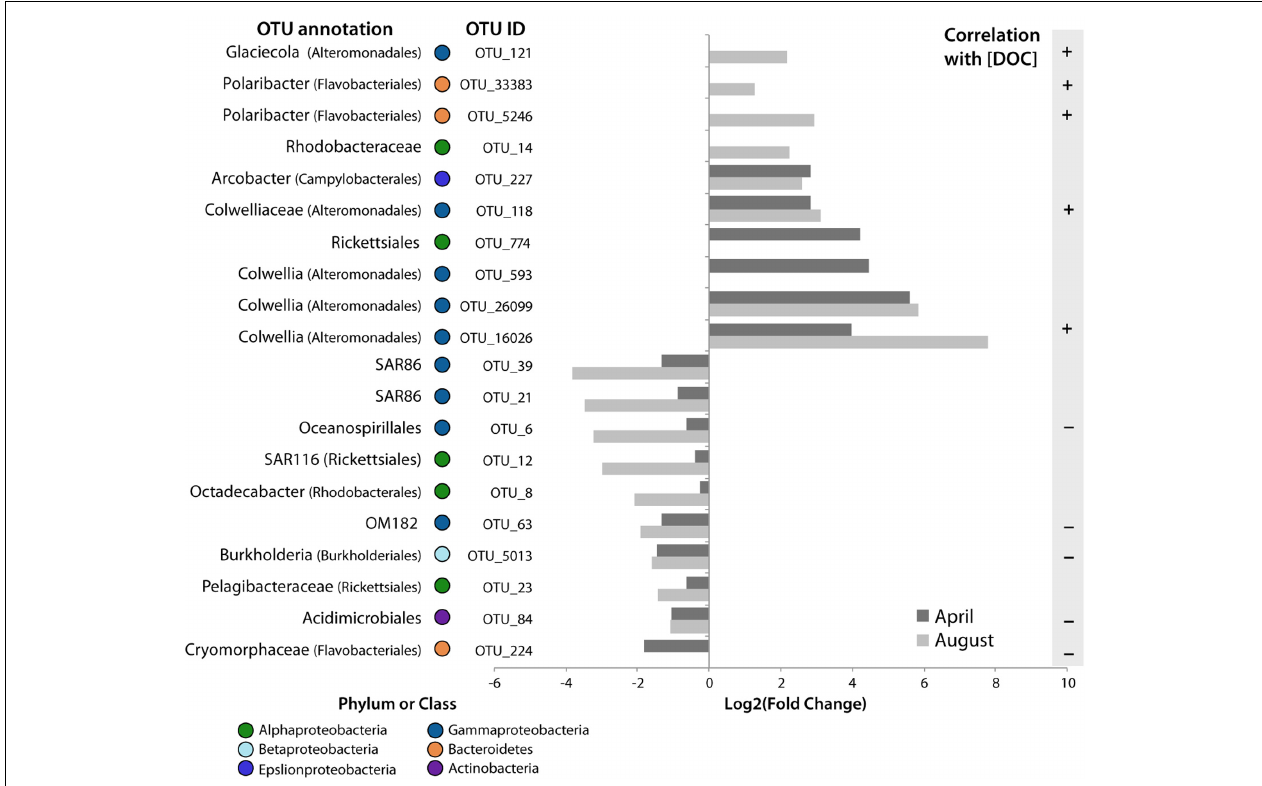
FIGURE 7 | Potential sentinels of increasing tDOM. Log2 of the fold change in relative abundance of OTUs that were found to significantly increase or decrease in tDOM bioassays only. The amount of change at 4 days in each bioassay is plotted. Taxonomic classification of the OTU is noted to the right of the OTU# (more detailed classifications are provided in Figure 2 ). The presence of a significant ( p < 0.05) correlation with DOC concentration is also indicated to the right of the plot. OTU_593 and OTU_33383 also increased in the April bioassay but this change could not be calculated since it was not present at the start of the experiment in these